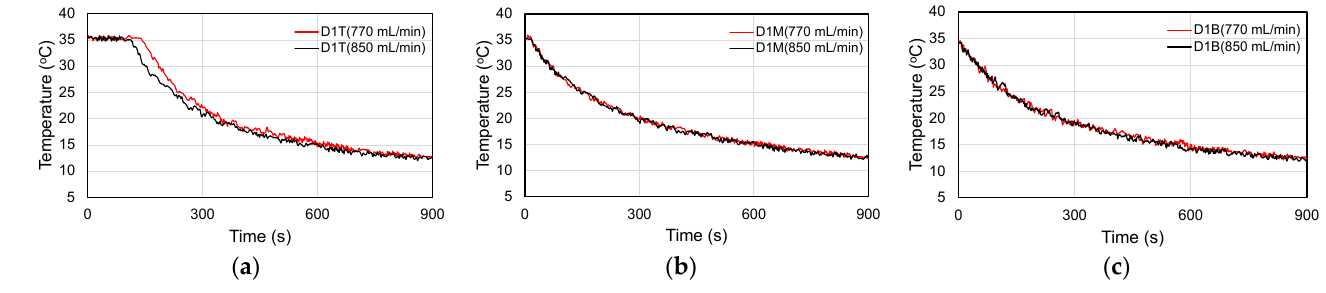
Figure 4. Temperatures variation comparisons between flow rates of 770 and 850 mL/min at the initial temperature of 35 °C: ( a ) top layer; ( b ) middle layer; ( c ) bo tt om layer.